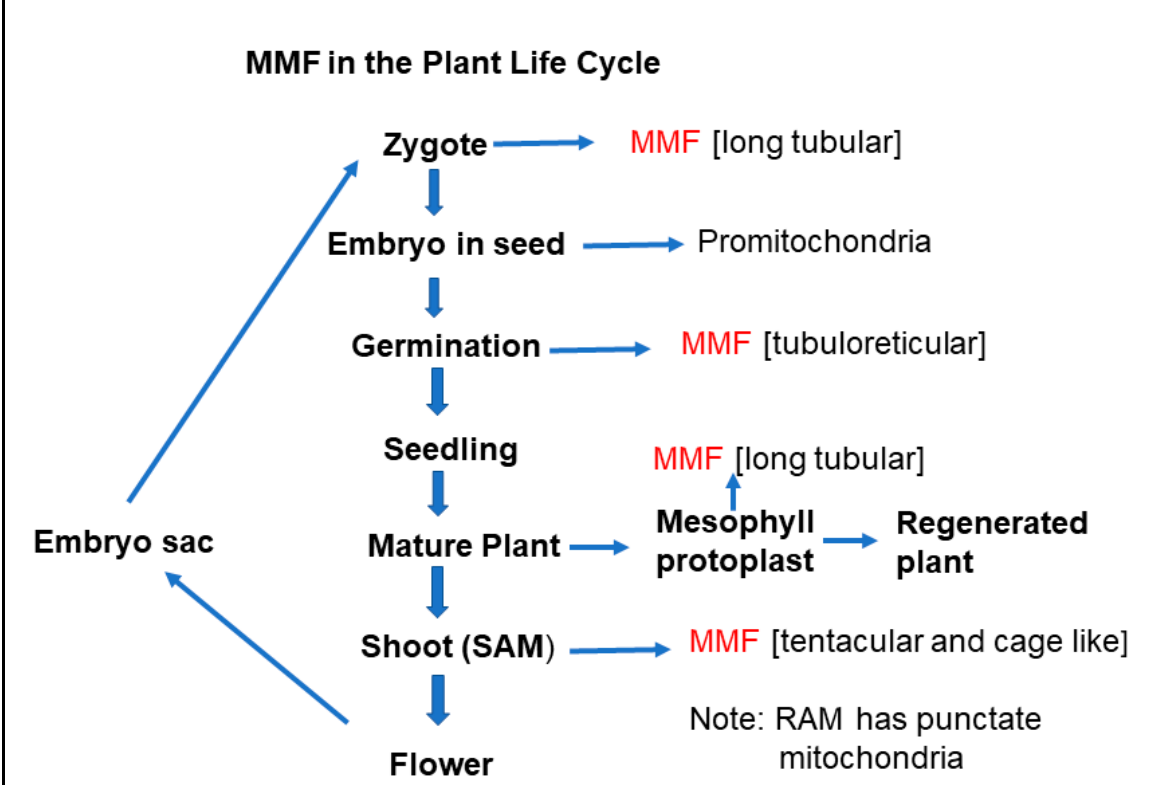
Figure 2. Massive mitochondrial fusion (MMF) in the plant life cycle. Diagram based on information presented in Section 5, mainly from references [7,18,82,83,86].